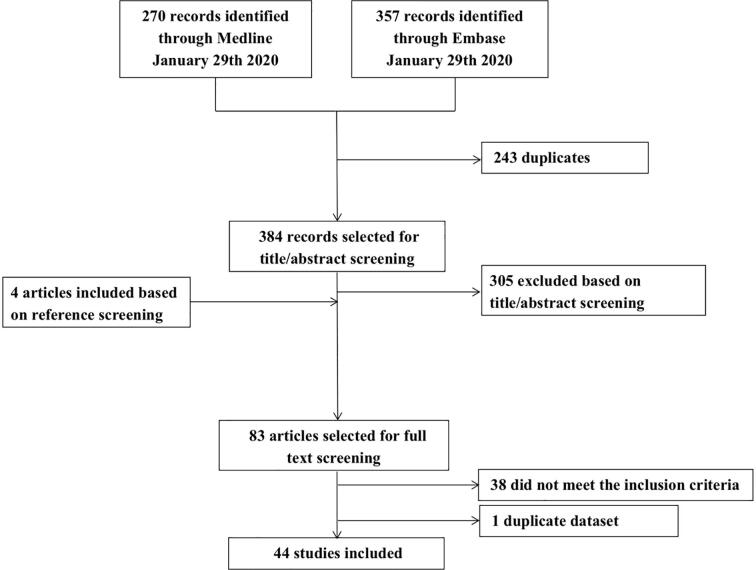
Flow chart of study selection.